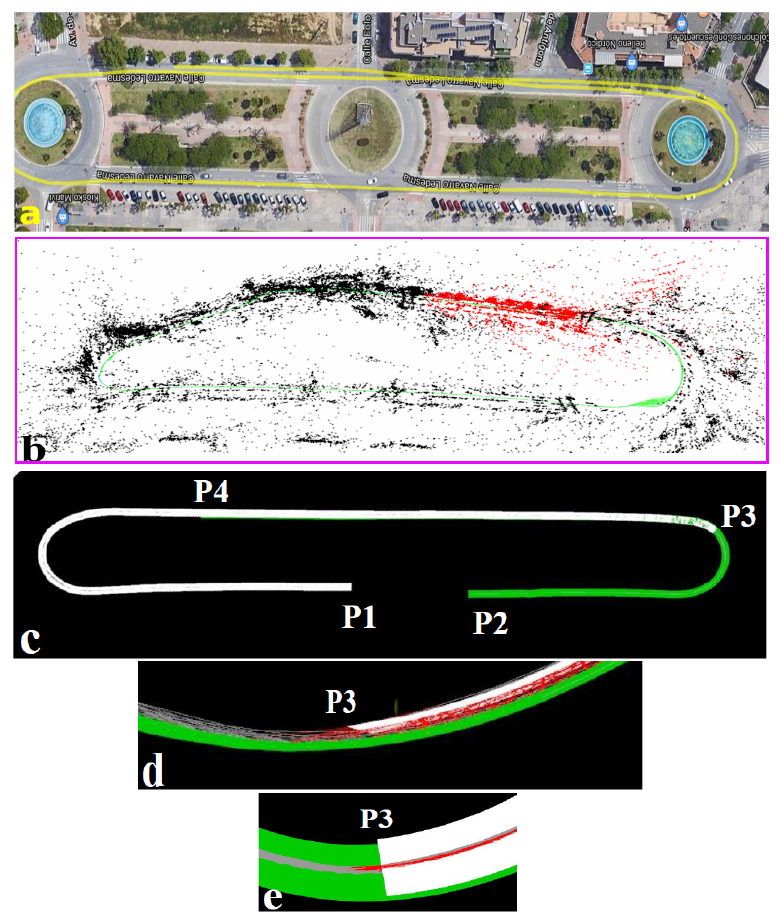
Figure 2. Accuracy improvement using pose-consistency evaluation. ( a ) The GPS ground truth path of Malaga 07 data set [44] on Google map. ( b ) The map generated using ORB-SLAM2 [3]. ( c ) The merged camera track with our pose-consistency evaluation. White and green show the two individual camera tracks. ( d , e ) Magnified views show map fusion